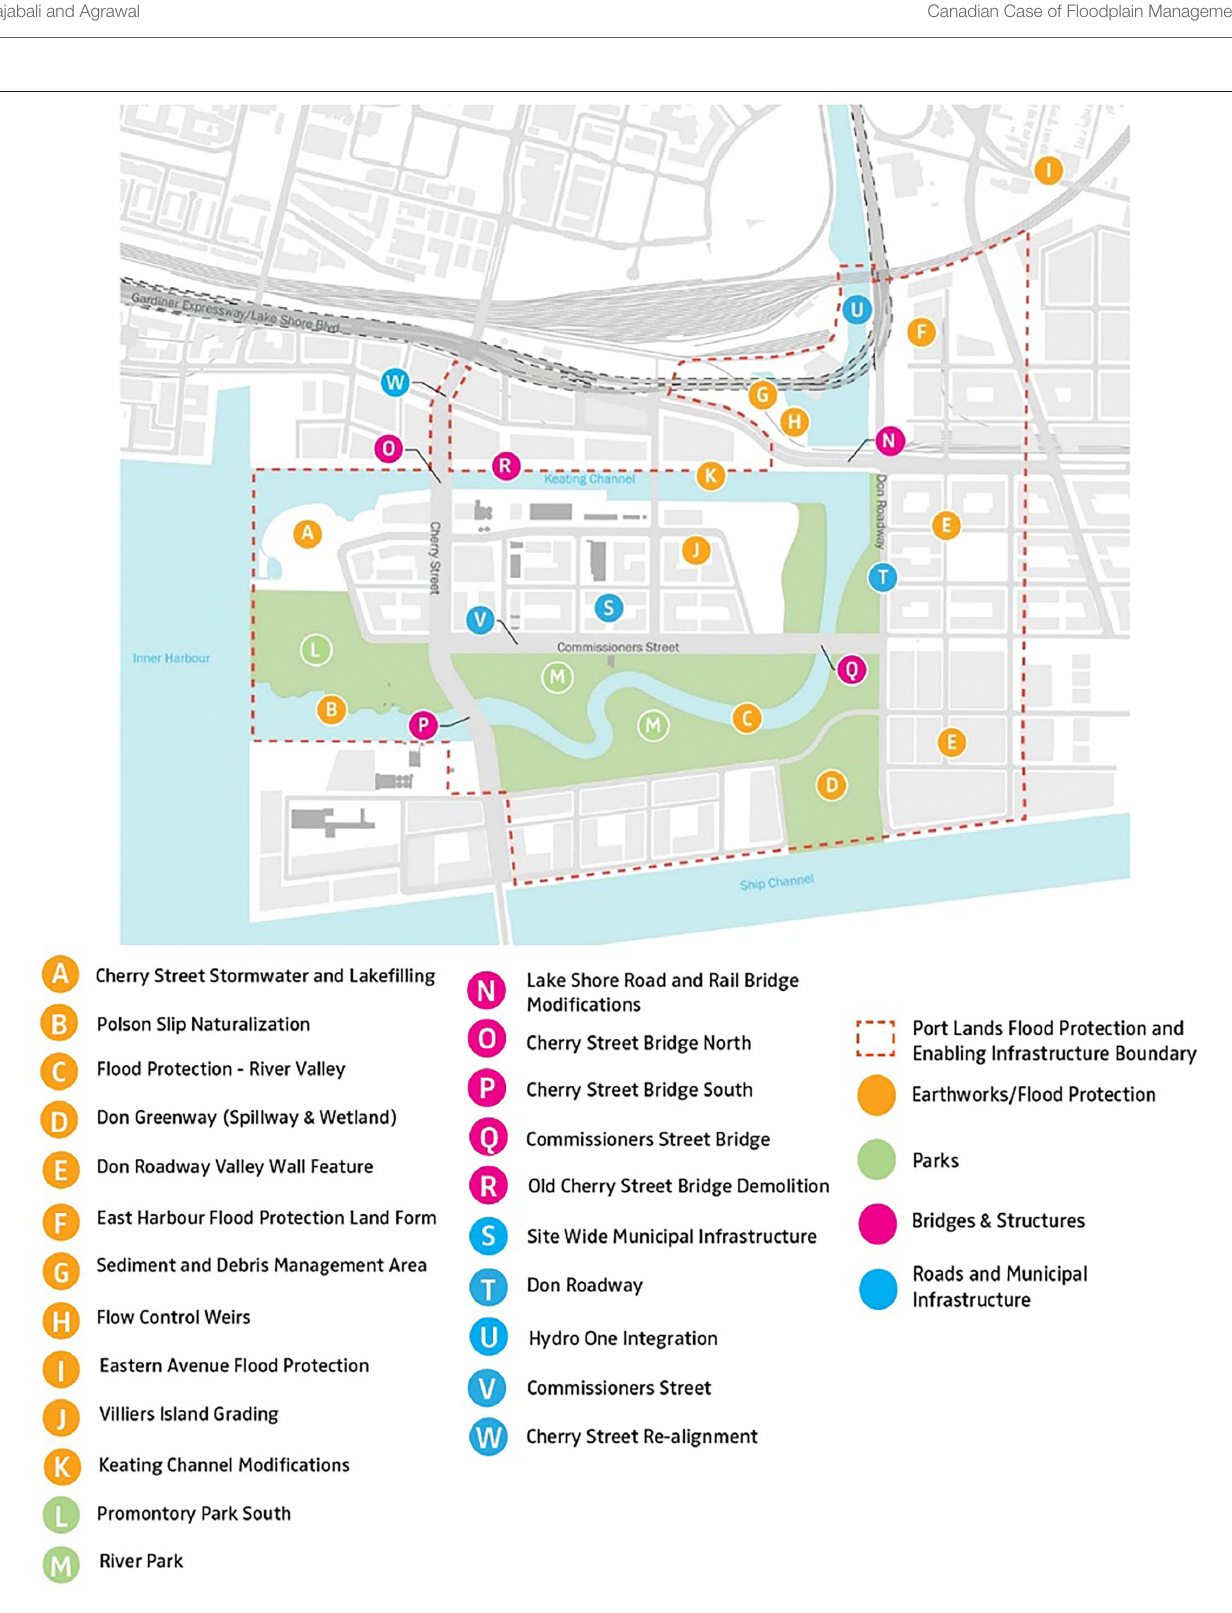
Frontiers in Water |